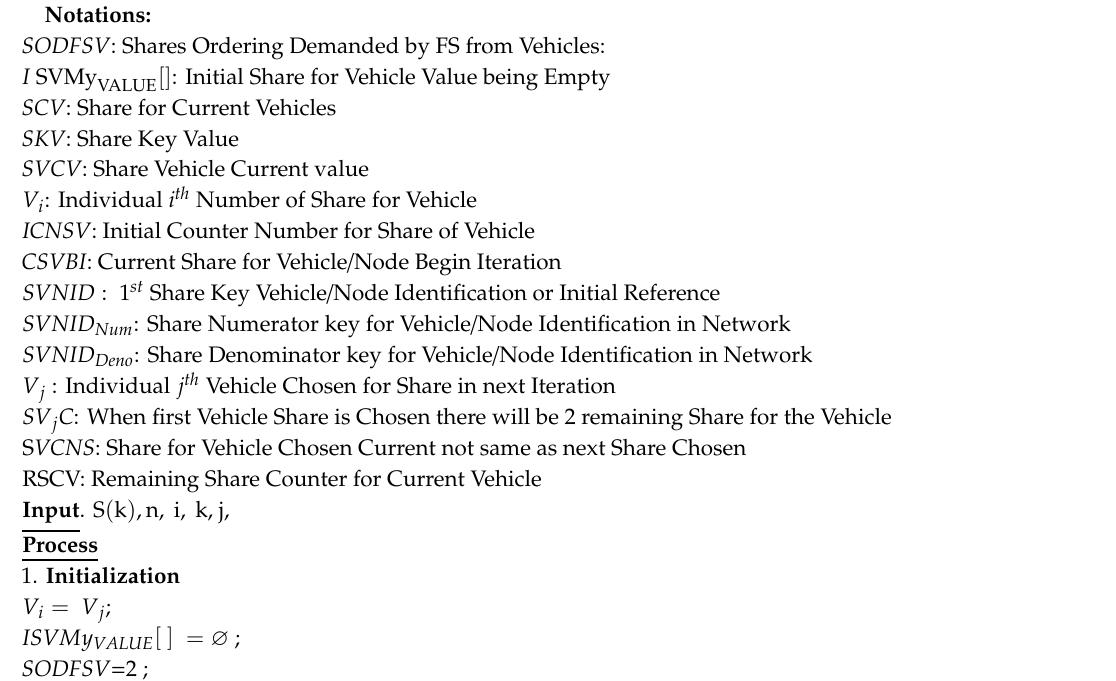
Pseudo Code Algorithm for Share